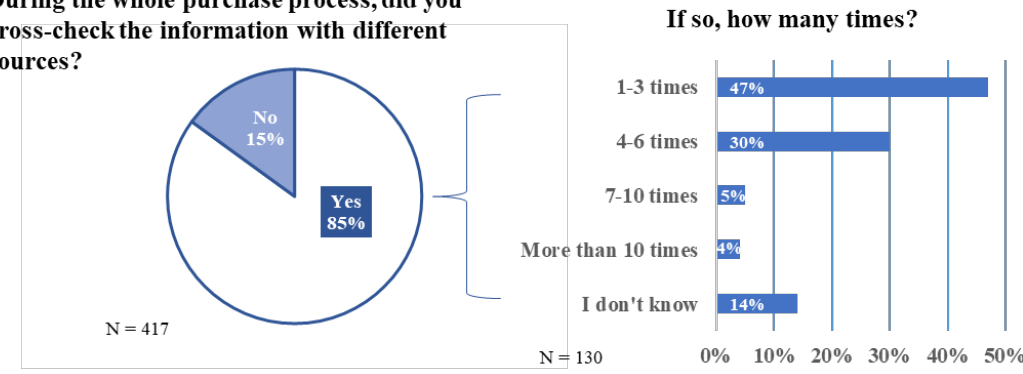
Figure 8. Information validation.